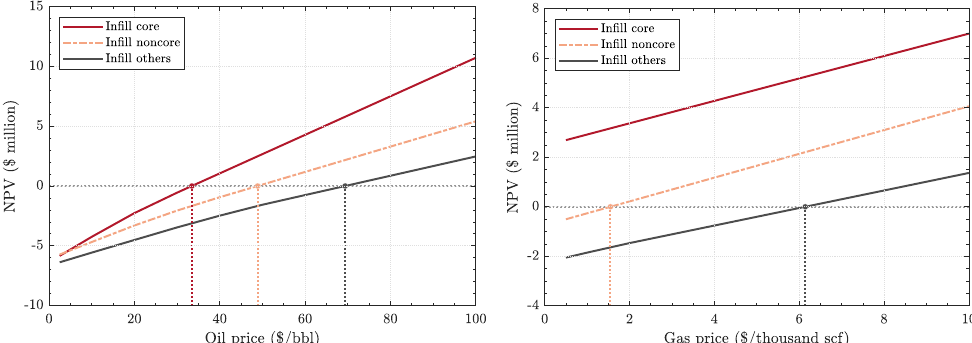
Figure 17. Economic analysis result for the Core, Noncore, and ‘Others’ area. Infilling the core areas is always profitable, even if oil price is $35/bbl, and at any gas price. If oil price is $52/bbl or gas price is $1.5/kscf, the noncore areas of the Permian become profitable. Operators should not bother with the ‘Others’ area, because the wells drilled there will not be profitable, unless oil price is $72/bbl and/or gas price is above